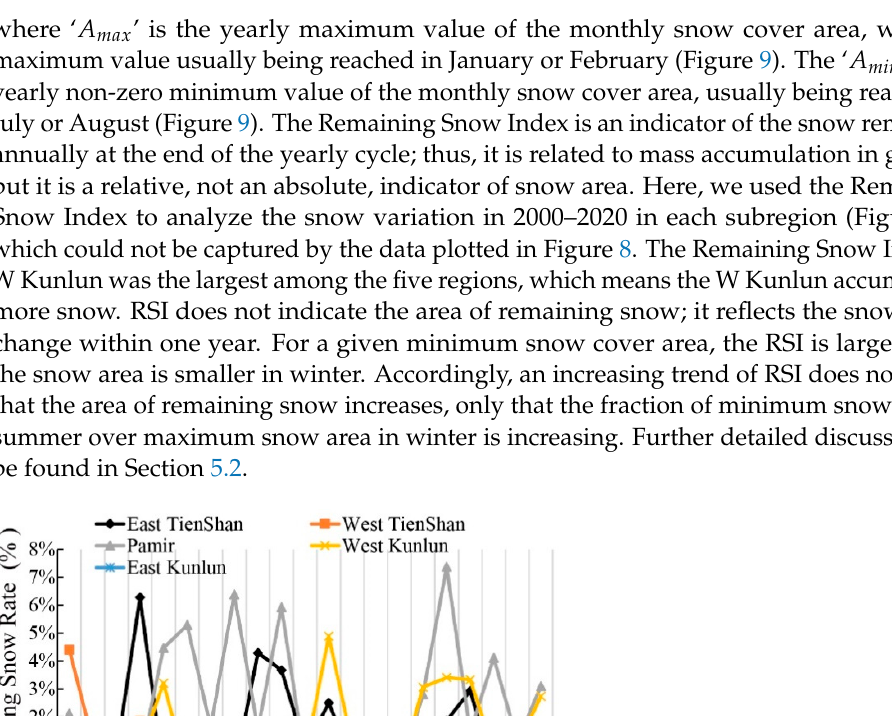
Figure 10. Remaining Snow Index in the five subregions of the Tarim Basin during 2000–2020.